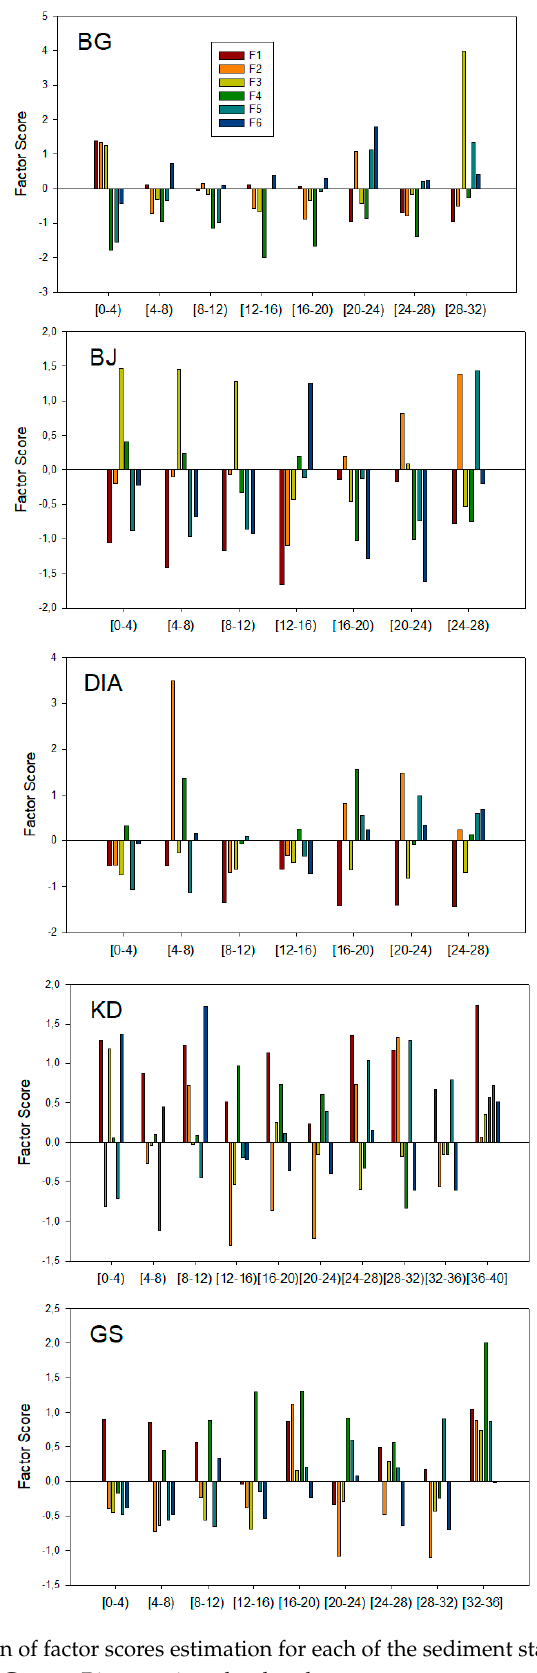
Figure 2. Representation of factor scores estimation for each of the sediment stations (BG, BJ, DIA, KD, and GS) selected in the Ganges River against depth values.